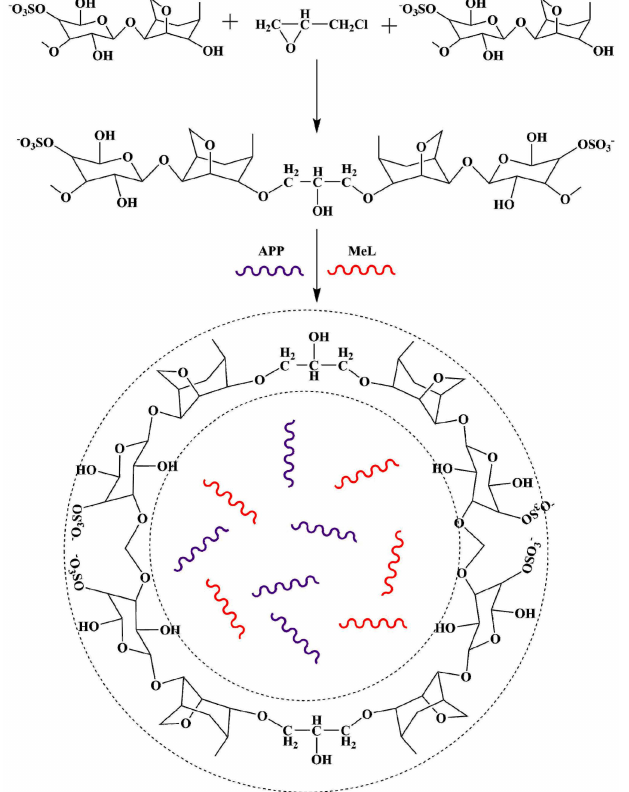
Figure 1. Preparation of the KC-IFR